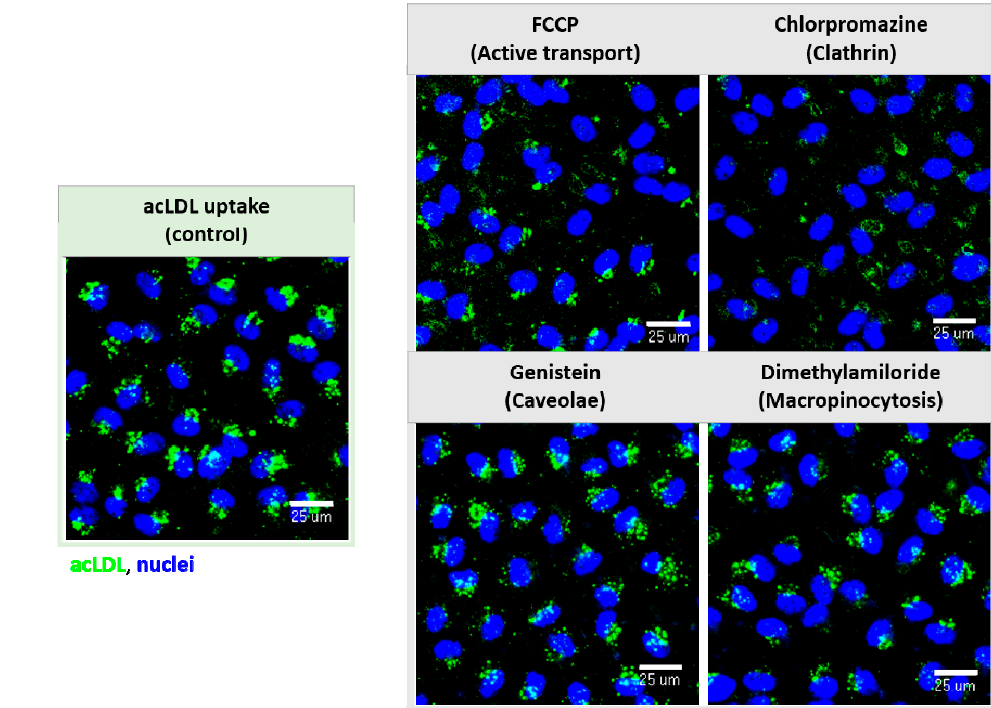
Figure 8. Receptor functionality and endocytic pathway inhibition. Fluorescence-labeled acetylated LDLs (acLDLs) exposed to the inhibitors for the ATP synthesis (FCCP), for caveolae (Genistein) and clathrin-mediated transcytosis (Chlorpromazine) and macropinocytosis (Dimethylamiloride) pathways. AcLDL uptake within the BLECs decreased when FCCP and Chlorpromazine were present, showing the functionality of the receptors. Images taken by the ImageXpress Micro Confocal High-Content Imaging System, objective 20 × (scale bar = 25 µm).